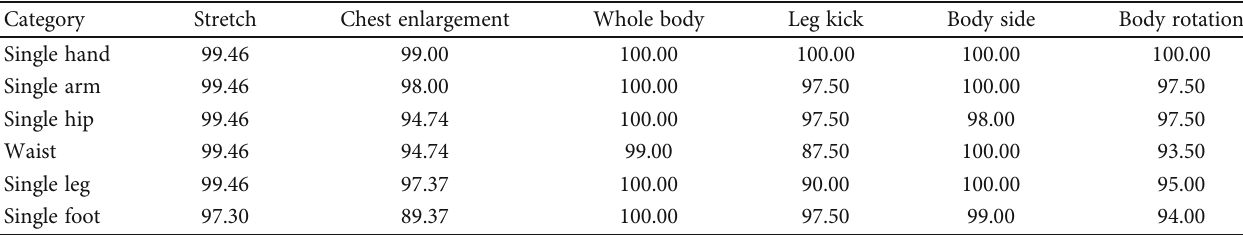
Table 3: Recognition rate based on three-axis acceleration and angular velocity.